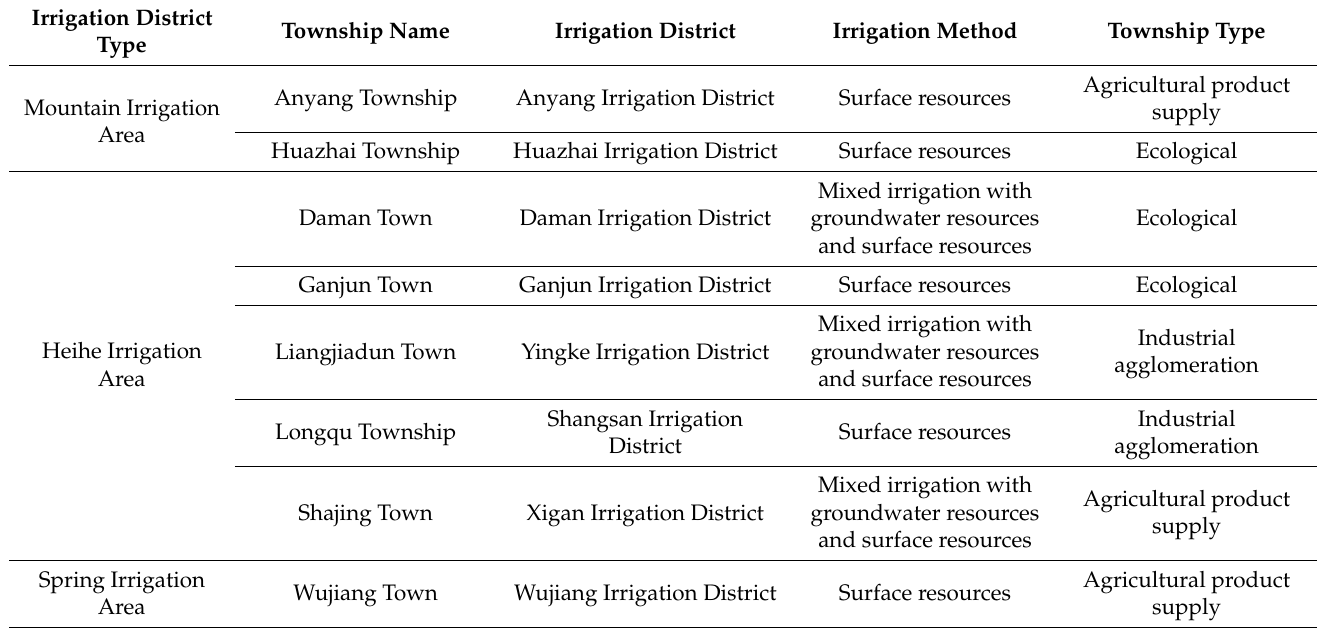
1. Table 1. Description of the eight studied Table 1. Description of the eight studied townships.